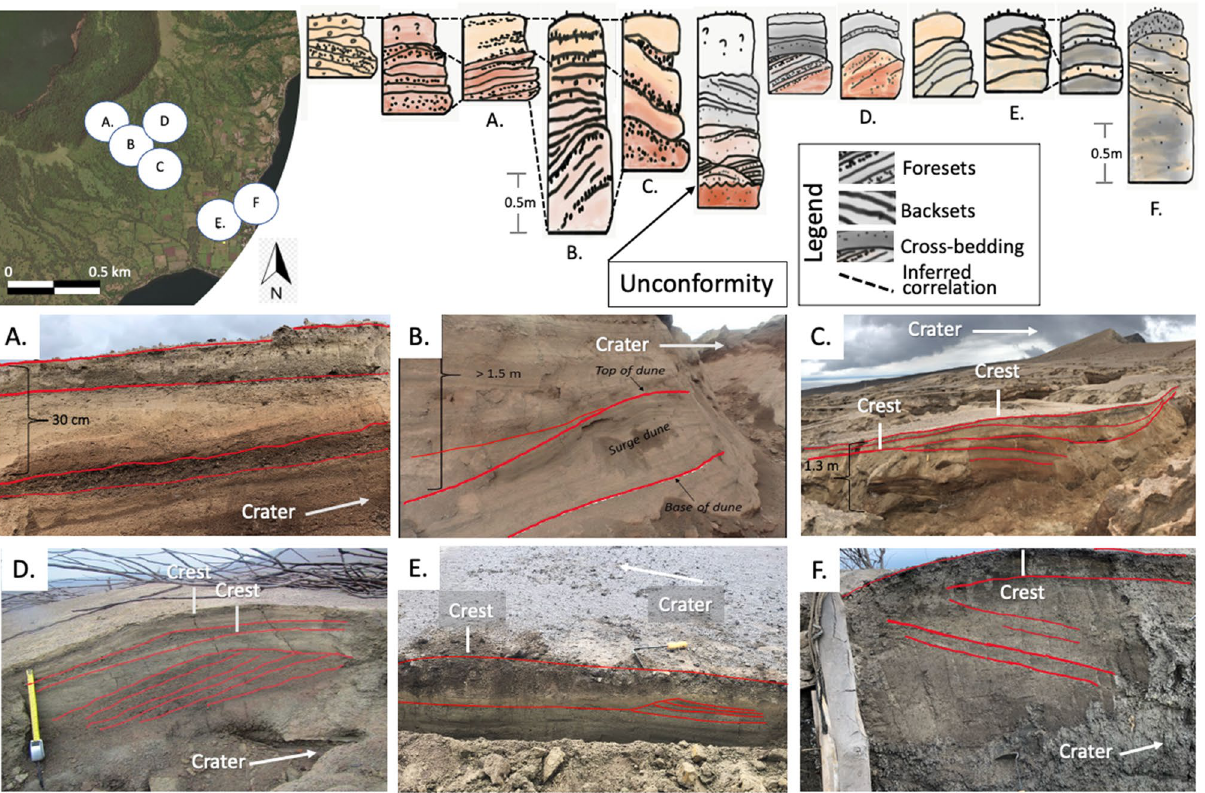
Figure 5. Stratigraphy of different dune bedforms in the southeast sector of TVI showing foresets, backsets, erosional features, curved surfaces, and ballistic fragments on the surface. See locations designated by letters A – F